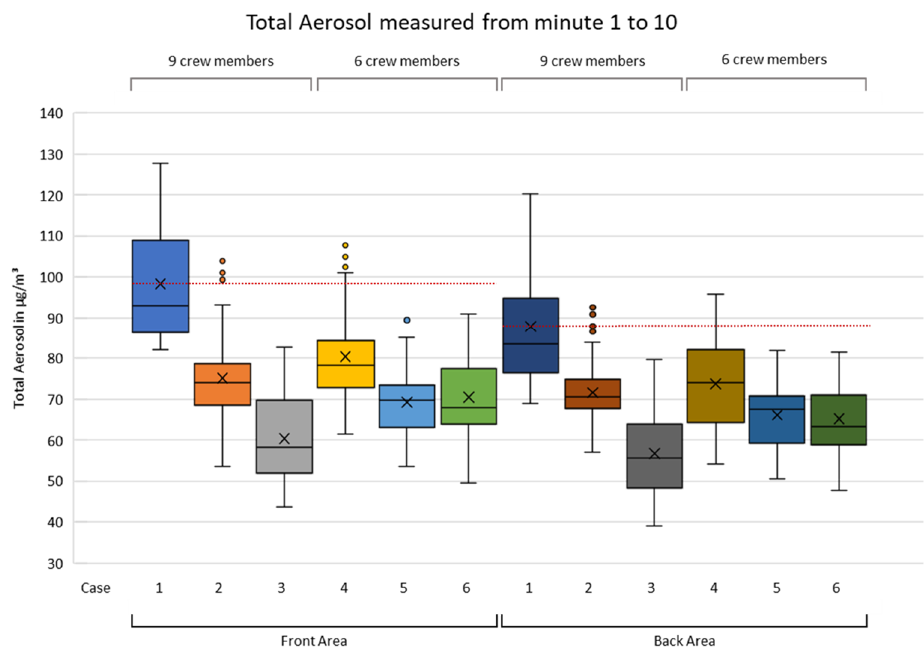
Figure 5. Total aerosol burden measured from minute 1 to 10.